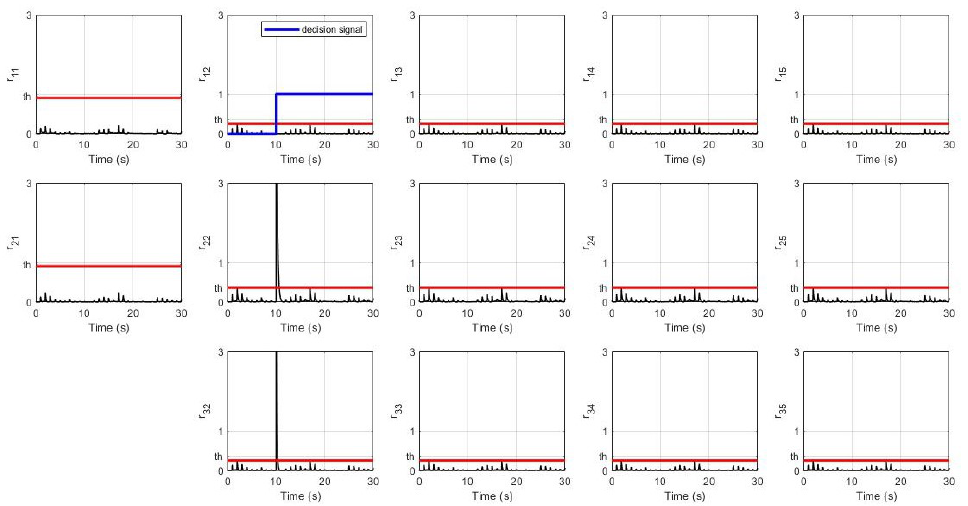
Figure 8. Residual signals with sensor S1 fault in the 2nd